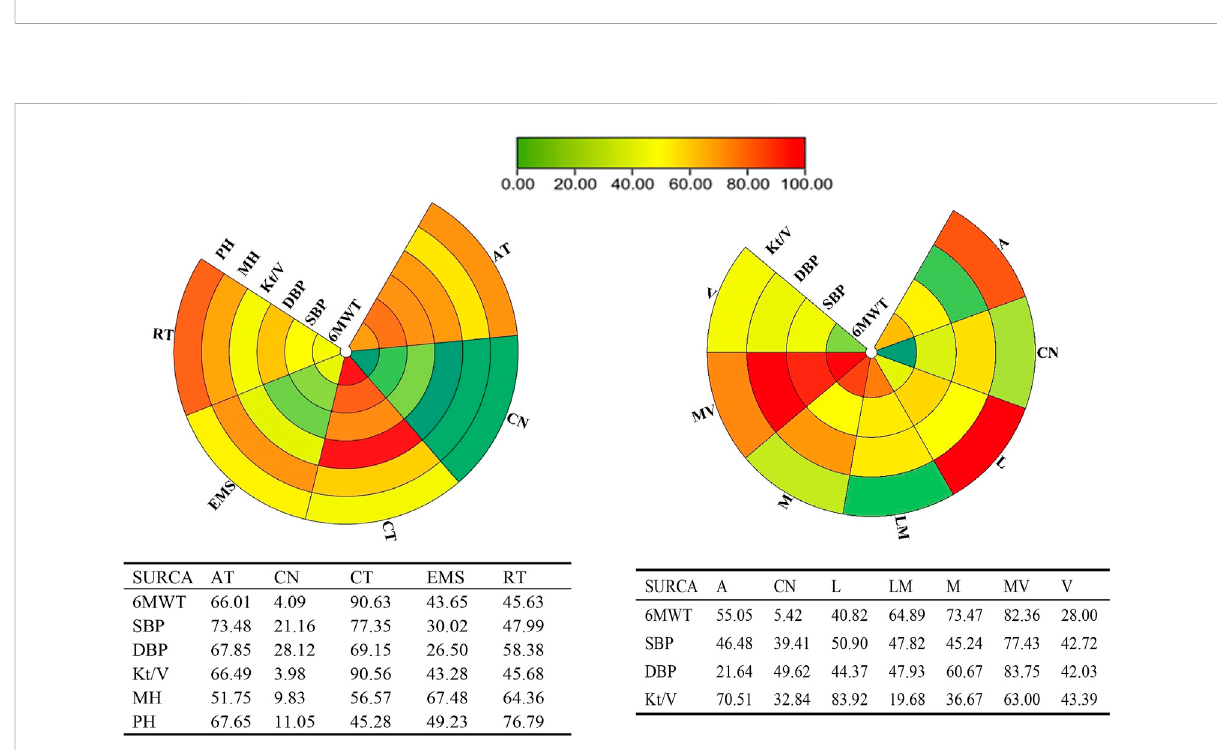
FIGURE 4 Schematic details of the treatments according to the surface under the cumulative ranking curve analysis